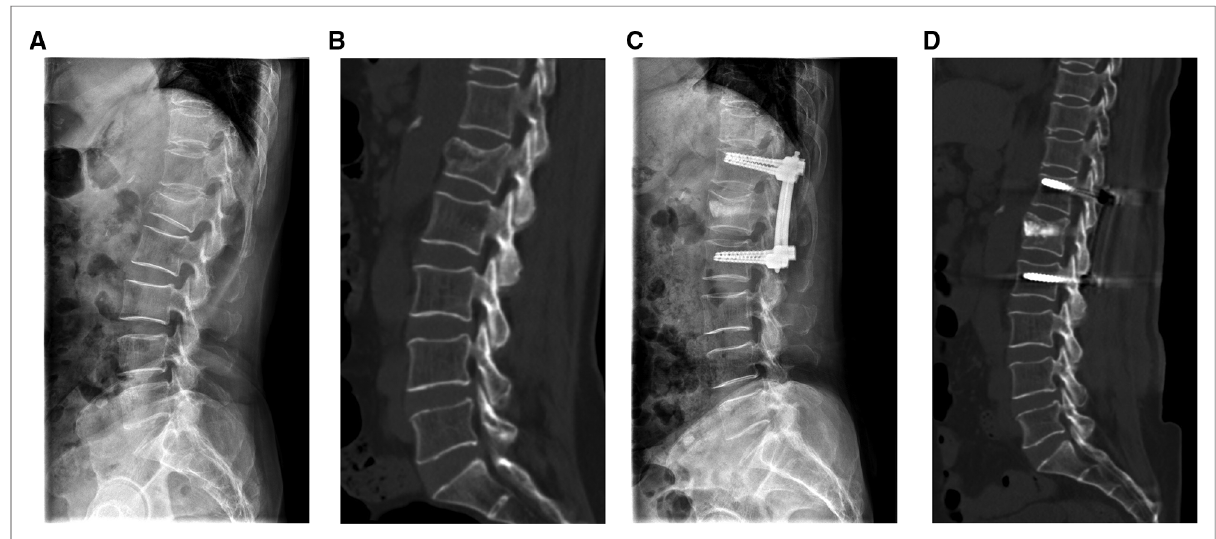
FIGURE 3 A patient treated with PPSR. ( A,B ) The preoperative sagittal radiograph ( A ) and CT image ( B ). ( C,D ) The postoperative sagittal radiograph ( C ) and CT image ( D